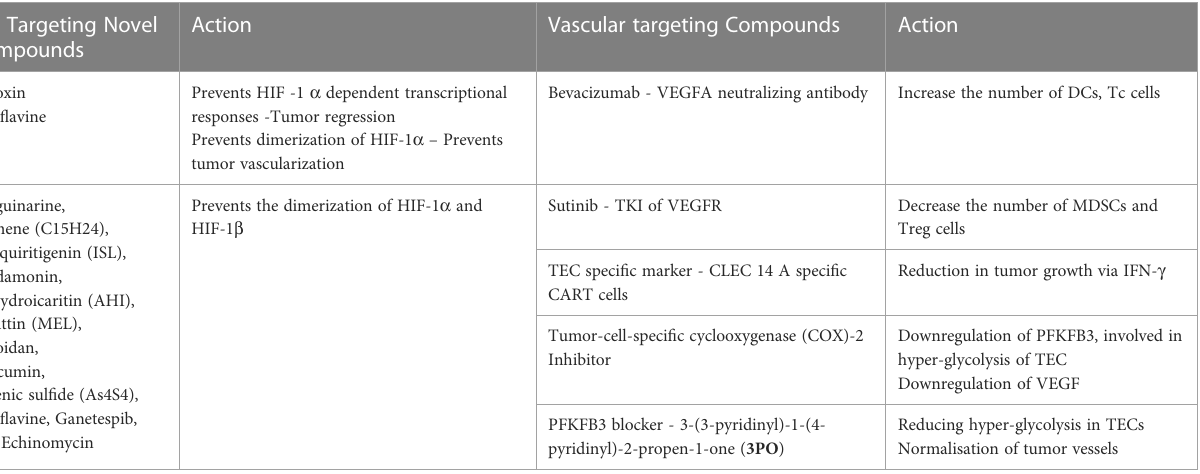
TABLE 2 Hypoxia and vascular targeting